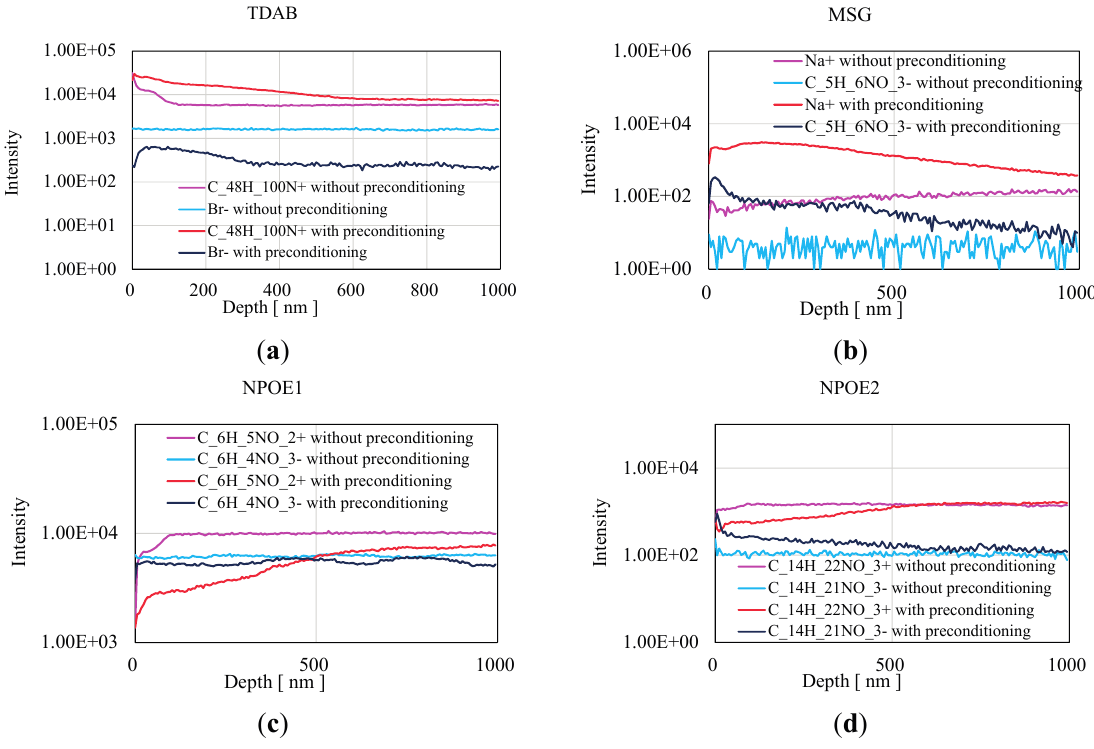
Figure 7. The result of GCIB-TOF-SIMS measurement. Four lines indicate the data of samples with and without the preconditioning using positive and negative ion. ATTENTION: The intensities cannot compare with each other samples because of no normalization. ( a ) 69 °C 48 H 100 N + and 81 Br − of TDAB; ( b ) 23 Na + and 128 C 5 H 6 NO 3 − of MSG; ( c ) 123 C 6 H 5 NO 2+ and 138 C 6 H 4 NO 3 − of NPOE; ( d ) 252 C 14 H 22 NO 3+ and 251 C 14 H 21 NO 3 − of